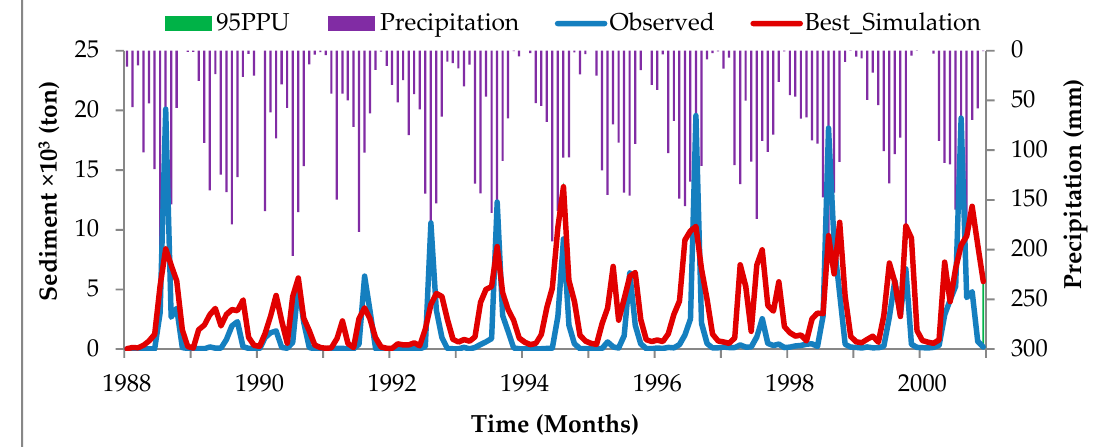
Figure 5. Sediment yield calibration for the Ketar River.